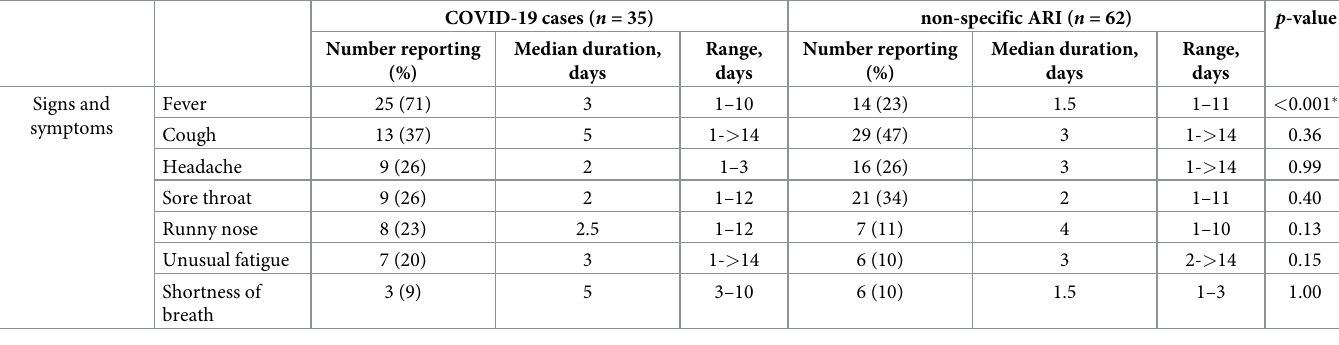
Table 2. Signs and symptoms of Australian passengers diagnosed with COVID-19 disease (n = 35) and non-specific ARI (n = 62), excluding